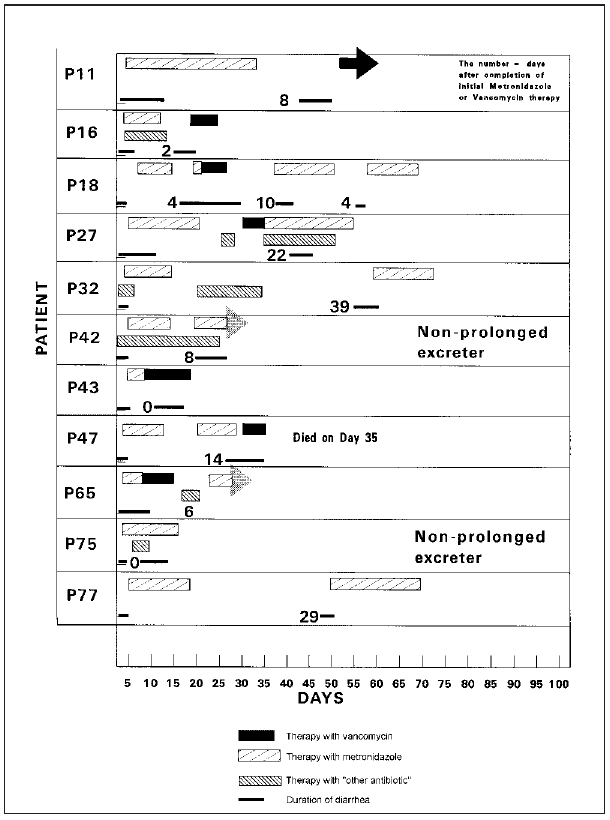
Figure 2) Antibiotic therapy in patients who had recurrence of diarrhea. Patients with Clostridium difficile -associated diarrhea were prospectively followed for as long as the patient was in hospital (up to a maximum duration of 13 weeks). Although the patients were admitted at different times, the time line is given as days post enrollment in the study (ie, initial occurrence of diarrhea that was positive for Cdifficile toxin). The patients with a recurrence of diarrhea after appropriate therapy were graphed to correlate antibiotic therapy with time of diarrhea recurrence. The patients who were nonprolonged excreters have been identified. Therapy with vancomycin and metroni- dazole have been recorded on the top line for each patient, and ‘other antibiotic’ therapy has been recorded on the middle line. The lines that have arrows for antibiotic therapy indicate that the stop date for the antibiotic(s) was not indicated on the patient’s chart. Duration of diarrhea has been indicated on the bottom line for each patient. The number given just before the recurrence of diarrhea indicates the numberofdaysthatelapsedafterthecompletionoftheFIRSTcourseof metronidazole and/or vancomycin (given for the enrolling bout of diarrhea) until the diarrhea recurrence